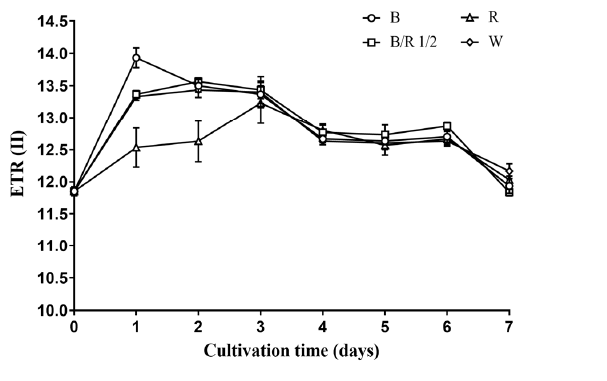
was no significant difference in the Y(II) values of H. pluvialis green cells cultivated under different light spectra.